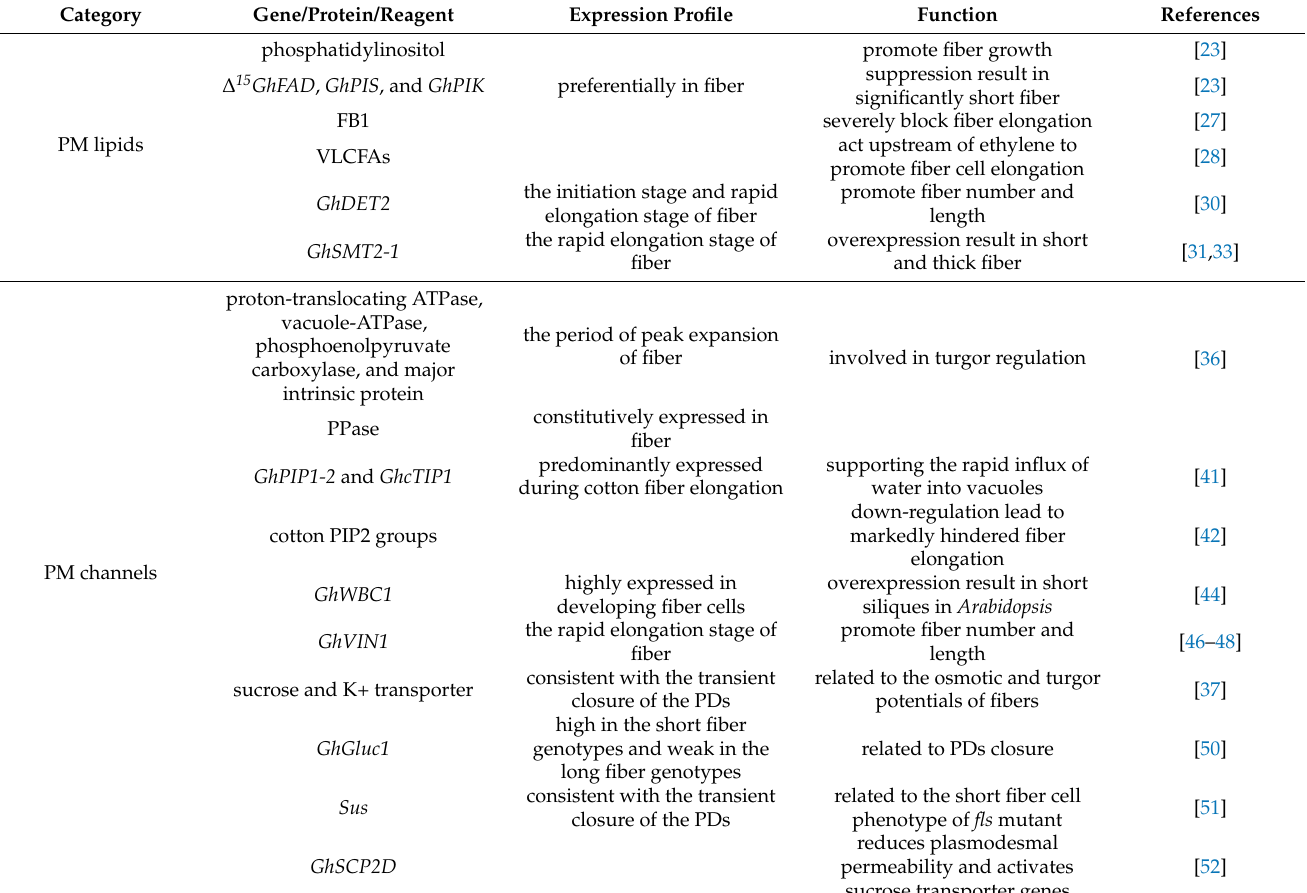
Table 1. The functions of membrane-related genes in cotton fiber